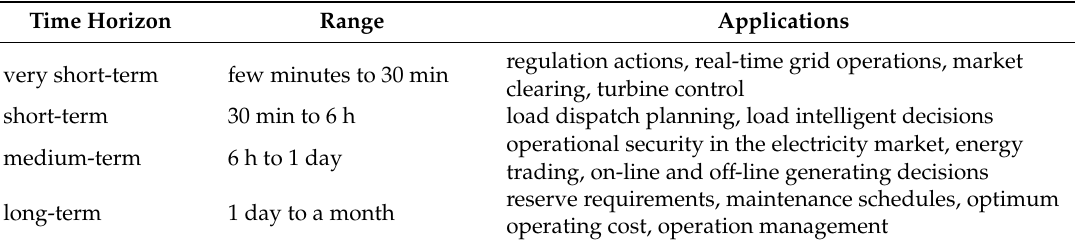
Table 1. Prediction horizons in wind power